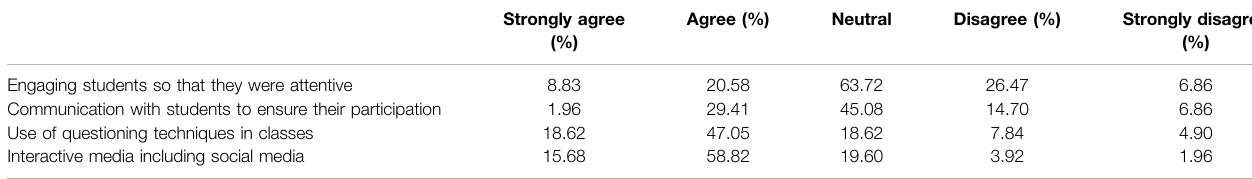
Strongly agree Agree (%) Neutral Disagree (%) Strongly disagree (%)